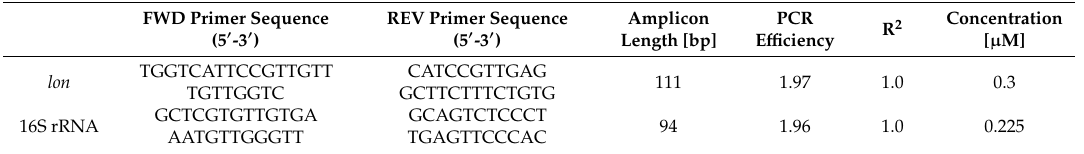
Table 4. Characteristics of primers used in gene expression